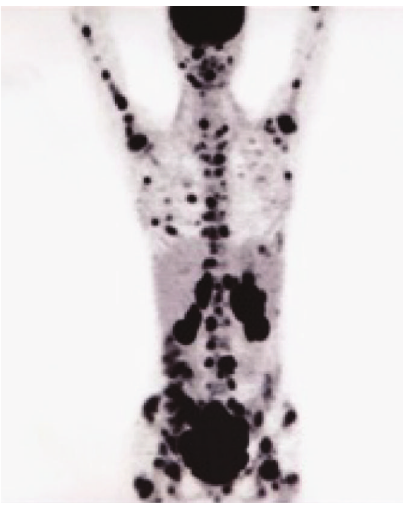
Figure 2: The positron emission tomography-computed tomogra- phy (PET-CT) shows a widespread pathological uptake of radio- tracer (F-FDG), including bones, kidneys, and an intraperitoneal pelvic